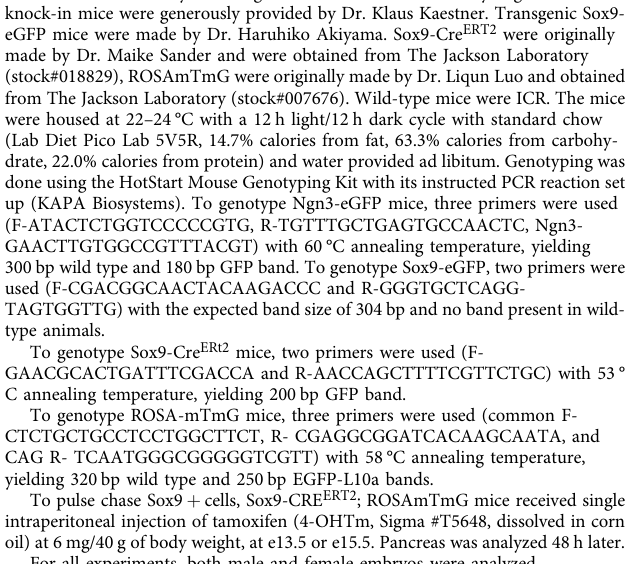
Fig. 8 Bipotent progenitors change with more alpha and tip cell genes expressed at e14.5 and more beta cell genes expressed at e16.5. a Pseudotemporal ordering of merged e14.5 and e16.5 single cells revealing the developmental trajectory of BPs as they differentiate. On left, tSNE plot of merged e14.5 and e16.5 single cells in clusters (top) and with original identities (bottom). On right, BPs branch depending on developmental stage of origin, with e14.5 BPs making a choice between maturation into e16.5 BPs or differentiation into endocrine cells (clusters on top; original identities on bottom). b Branched expression analysis modeling (BEAM) showing transcriptional kinetics as e14.5 BPs either mature to e16.5 BPs or differentiate into EP, alpha, or beta cells. Examples of genes from each cluster are shown to the right, including Dcdc2a , which is conserved in both e14.5 and e16.5 BPs, and Amotl2 , which is increasing as e14.5 BPs mature into e16.5 BPs. c Schematic for AMOTL2 knockdown in hESC-derived EPs. Lentivirus with pGIPZ AMOTL2 shRNA was transduced into hESCs at day 0 of the EP stage and cells were collected for analysis after 5 days in basic DMEM/B27 media. d AMOTL2-LOF cells resemble the e14.5 phenotype, with more GCG and less INS. qPCRs showing INS and GCG expression 5 days after loss of AMOTL2 in hESC-derived EPs. Samples are normalized to TBP . N = 3 biological replicates. Scale bars are SEM, * p < 0.05 by Student ’ s t -test. e Immunostaining of INS, GCG, and CHGA